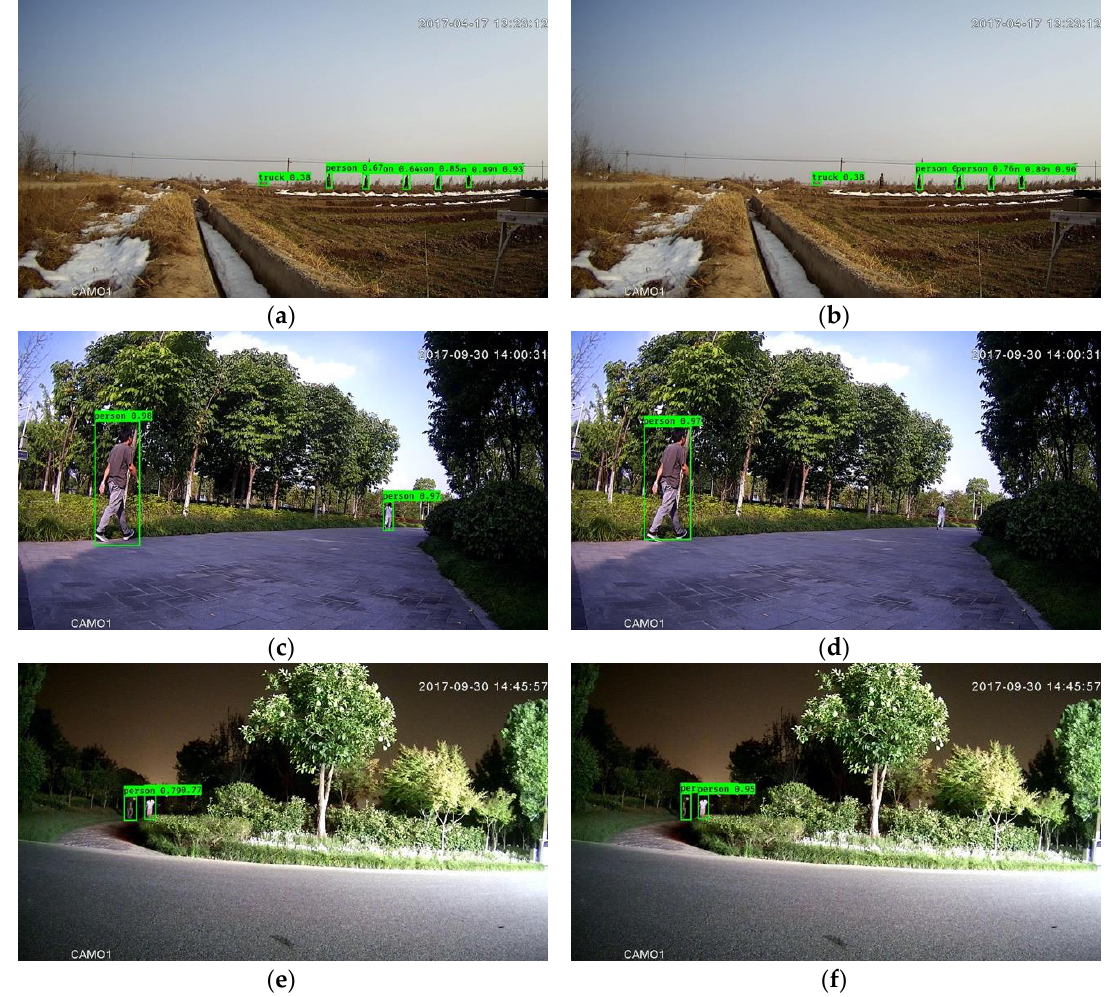
Figure 6. Outcomes of the framework with 416 × 416 input size without downsampling ( a,c,e ) and with downsampling ( b,d,f ). The left column and right column correspond to the same images. Table 6. Results of the framework with focal loss, with and without downsampling on different input sizes.